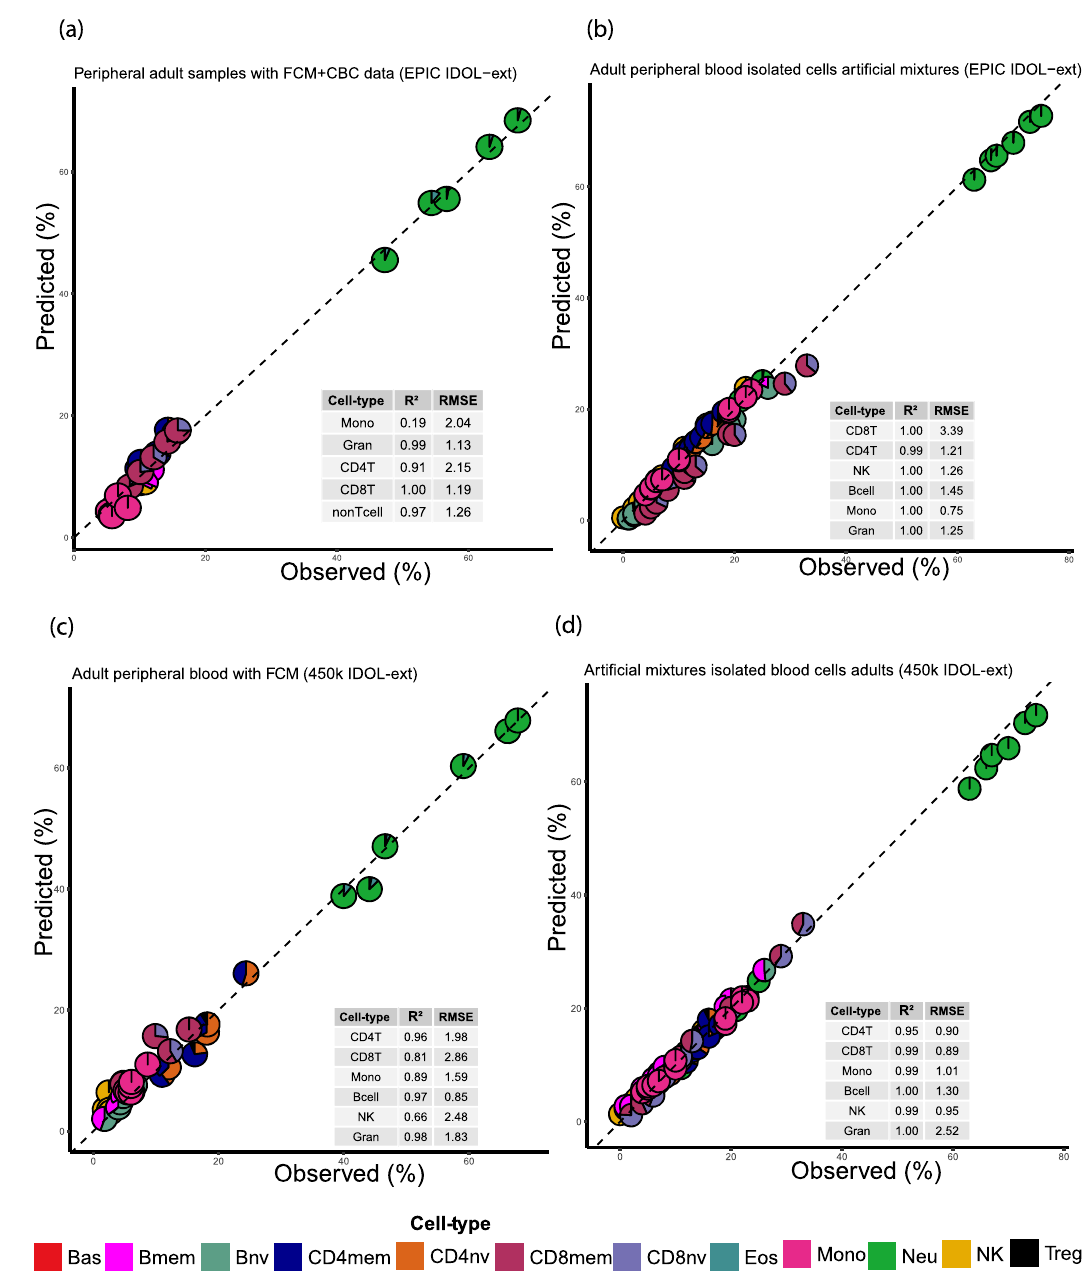
Fig. 4 Validation of the library using fl ow cytometry-FCM and independent arti fi cial mixtures for adult peripheral blood. a and b Vaalidation of the EPIC IDOL-Ext. c and d Validation of the 450k IDOL-Ext. The area of each pieplot corresponds to the estimated proportion of the cell types within each group. Gran (Granulocytes) corresponds to the sum of Neu-neutrophils, Eos-eosinophils, and Bas-basophils. CD4T corresponds to the sum of CD4 + T cells naïve-CD4nv, memory-CD4mem and Treg. CD8T corresponds to the sum of CD8 + T-cells naïve-CD8nv and memory-CD8mem. B cell to the sum of the naïve-Bnv and memory-Bmem. No basophils were detected in the samples illustrated in a . Additionally, in a , “ nonTcell ” (Bnv, Bmem, and NK) were not experimentally measured. Source data are provided as a Source Data fi